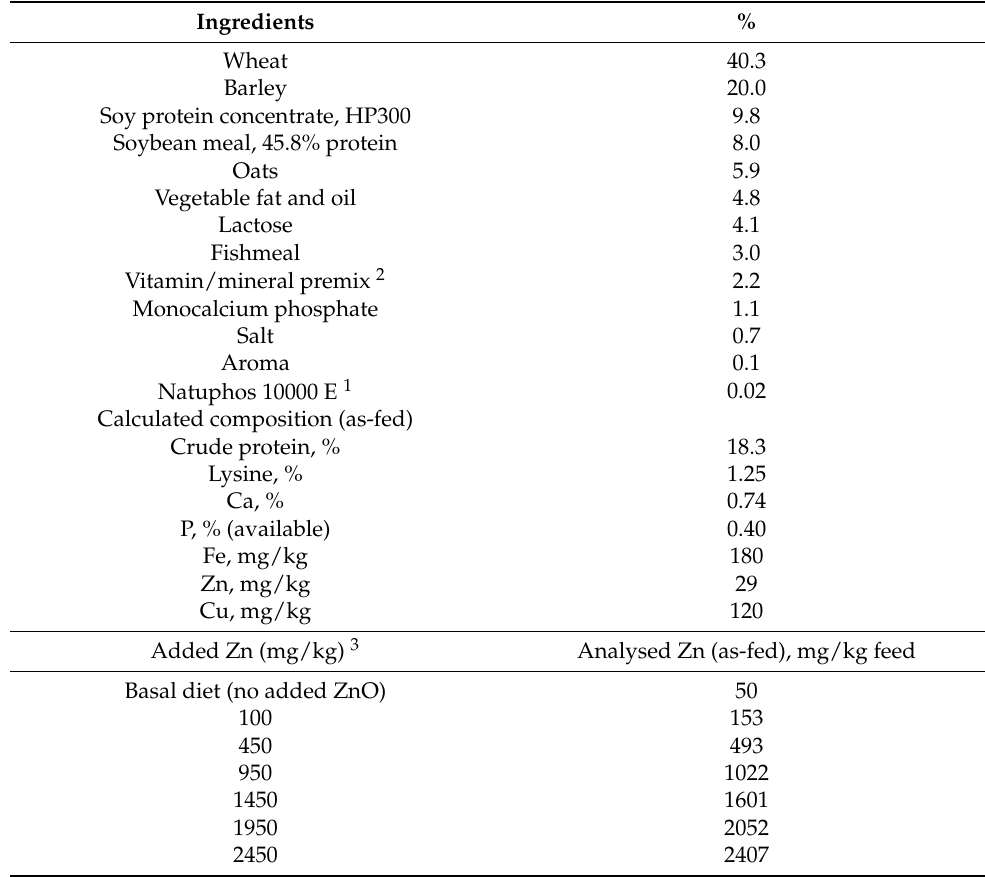
Table 1. Ingredients and calculated composition of the basal